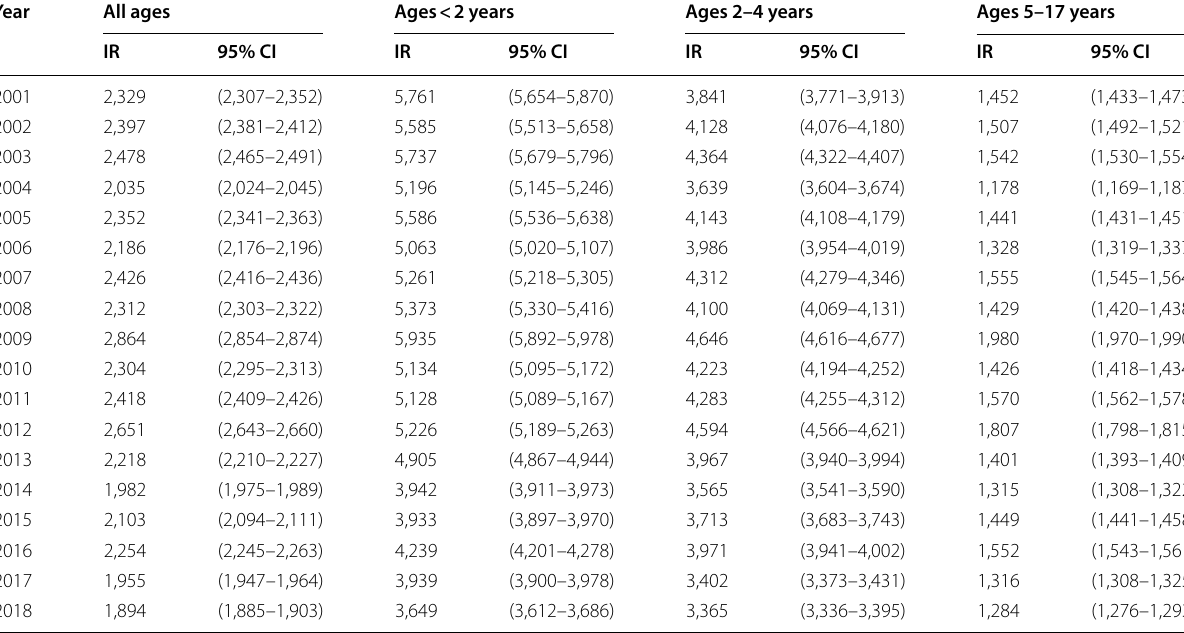
Table 10, and the monthly predicted IRs of ACP